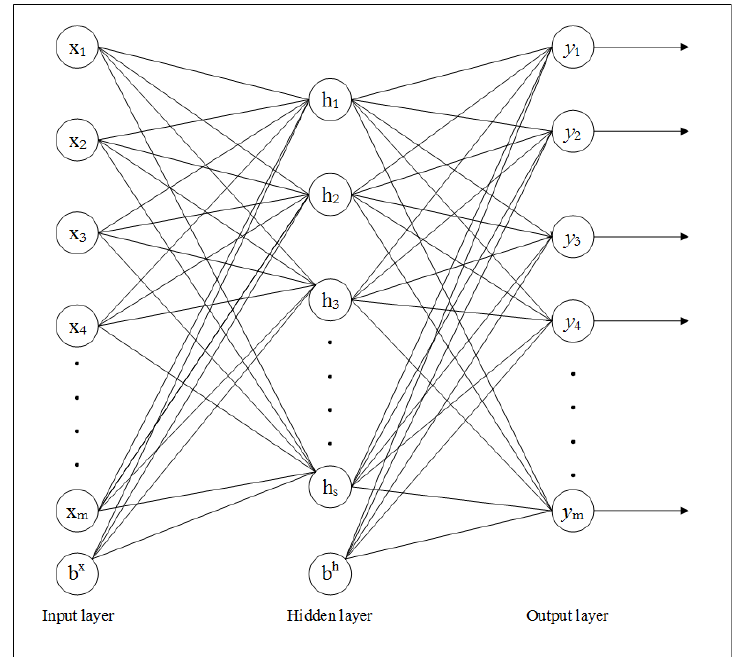
Figure 4. Basic structure of SAE.